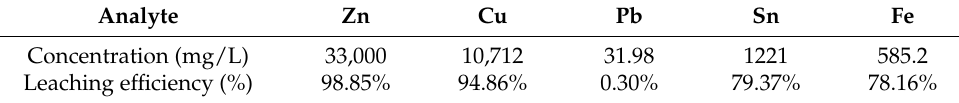
Table 4. Concentration of elements in solution after leaching in 1 M H 2 SO 4 at 20 ◦ C and L/S ratio